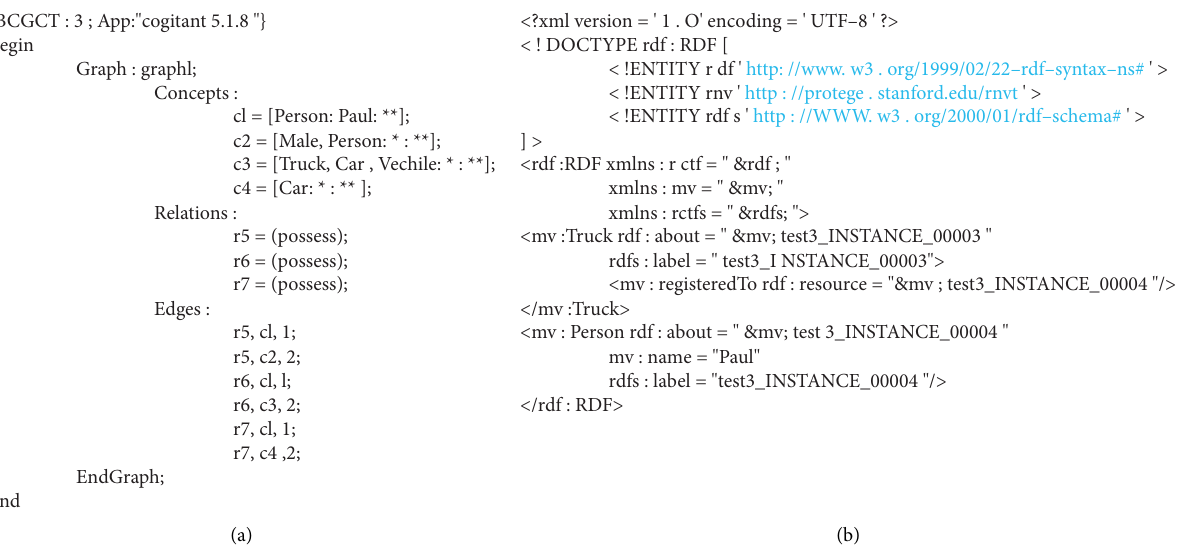
Figure 8: Description formats for relationship discovery task. (a) Cogitant social relationship graph. (b) RDF social relationship